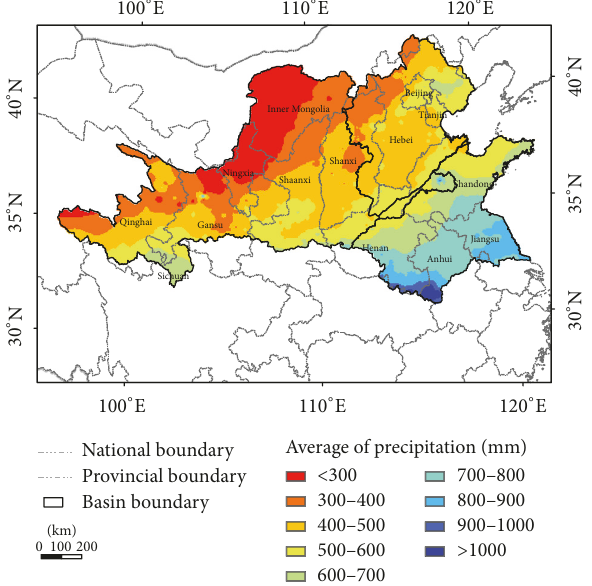
Figure22:Thespatialdistributionofmultiyearaveragerainlessdays from 1982 to